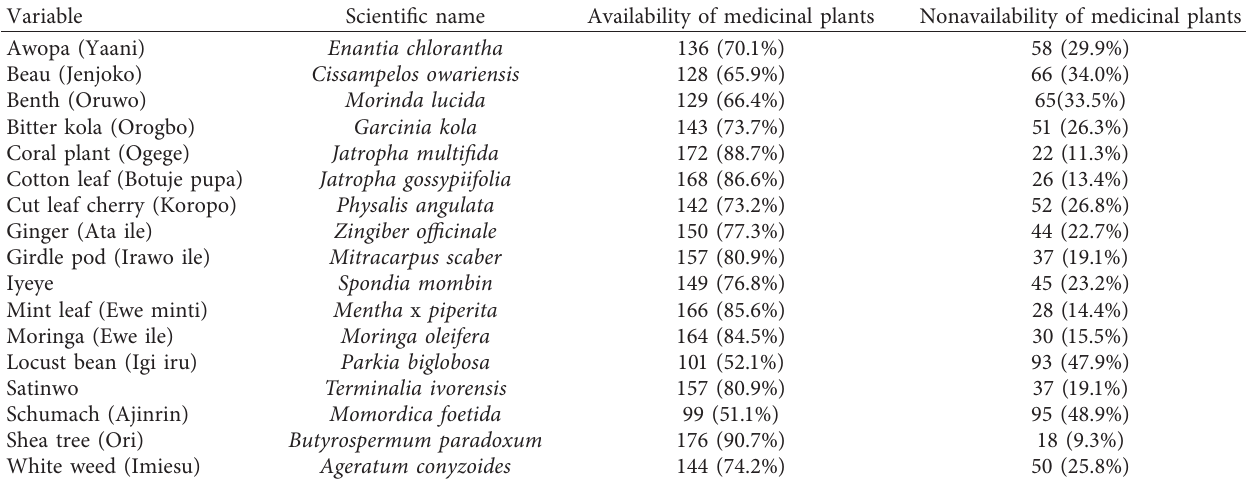
Table 2: Obtainable medicinal plants collected by the respondents ( N � 194).